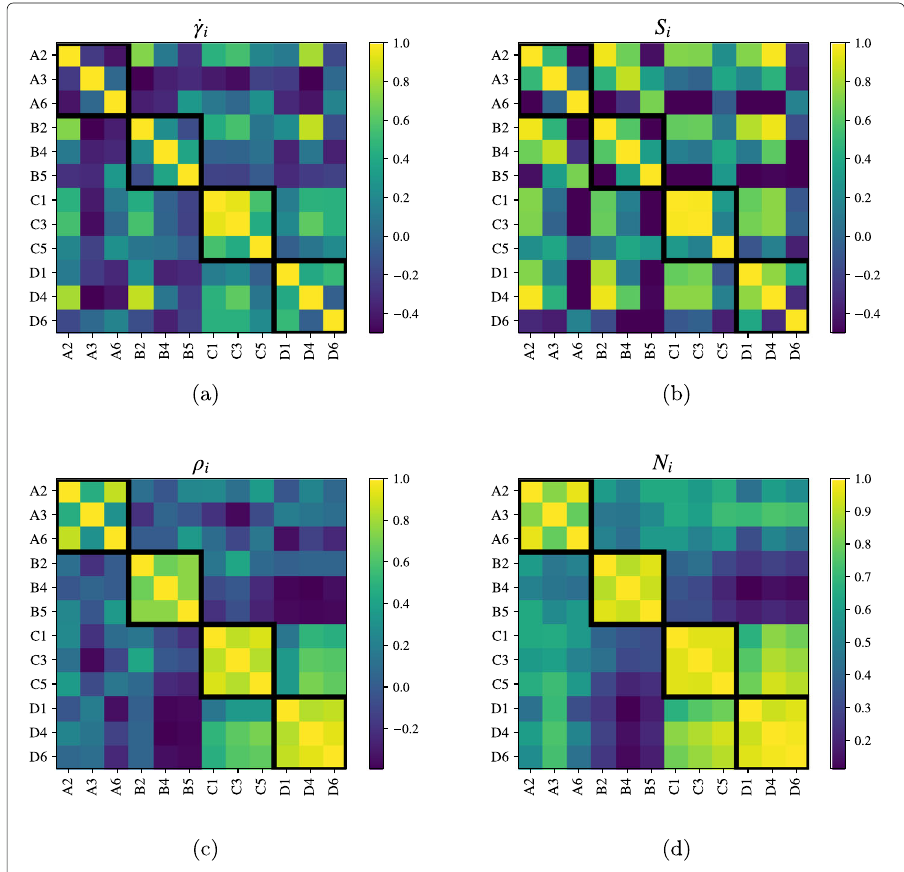
Fig. 3 Pearson correlation matrix plot of a shear strain rate ˙ γ i , b Schmid factor S i , c dislocation density ρ i , and d number of links per unit volume N i . Slip systems are labelled according to the Table 1. All 120 simulations whose hardening rates are shown in the inset of Fig. 2a are used in the plots. Heavy black boxes denote sets of coplanar slip